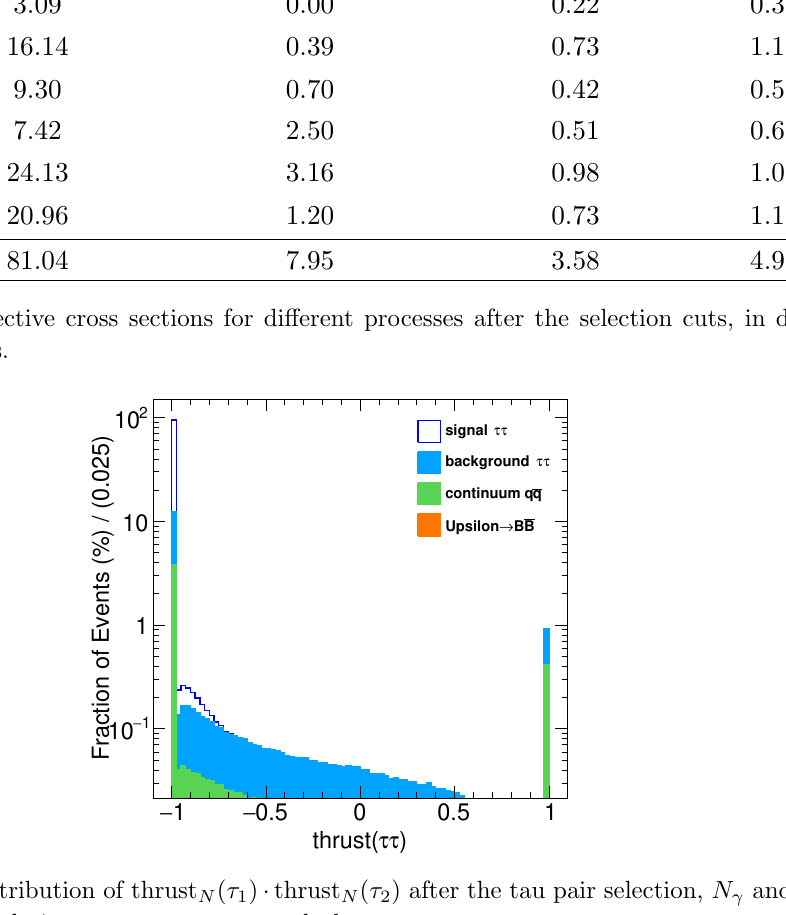
Figure 2 . The distribution of thrust N ( (cid:28) 1 ) (cid:1) thrust N ( (cid:28) 2 ) after the tau pair selection, N (cid:13) and thrust cuts. Di(cid:11)erent simulation components are